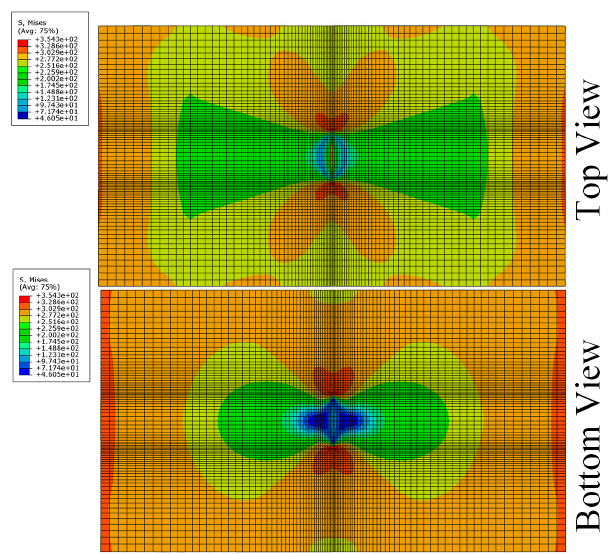
Figure 11. The contour of Mises stress in the Al plate under tensile loading.